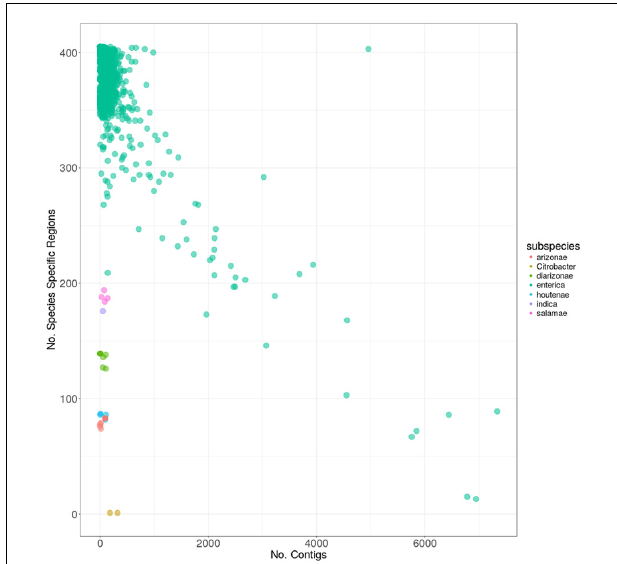
FIGURE 3 | The carriage of the 404 S. enterica species-specific regions, versus the number of contigs for each of the 4936 genomes. Colors indicate the subspecies within S. enterica as follows: red: arizonae, lime: diarizonae, teal: enterica, blue: houtenae, lavender: indica, magenta: salamae and yellow: sample with Citrobacter